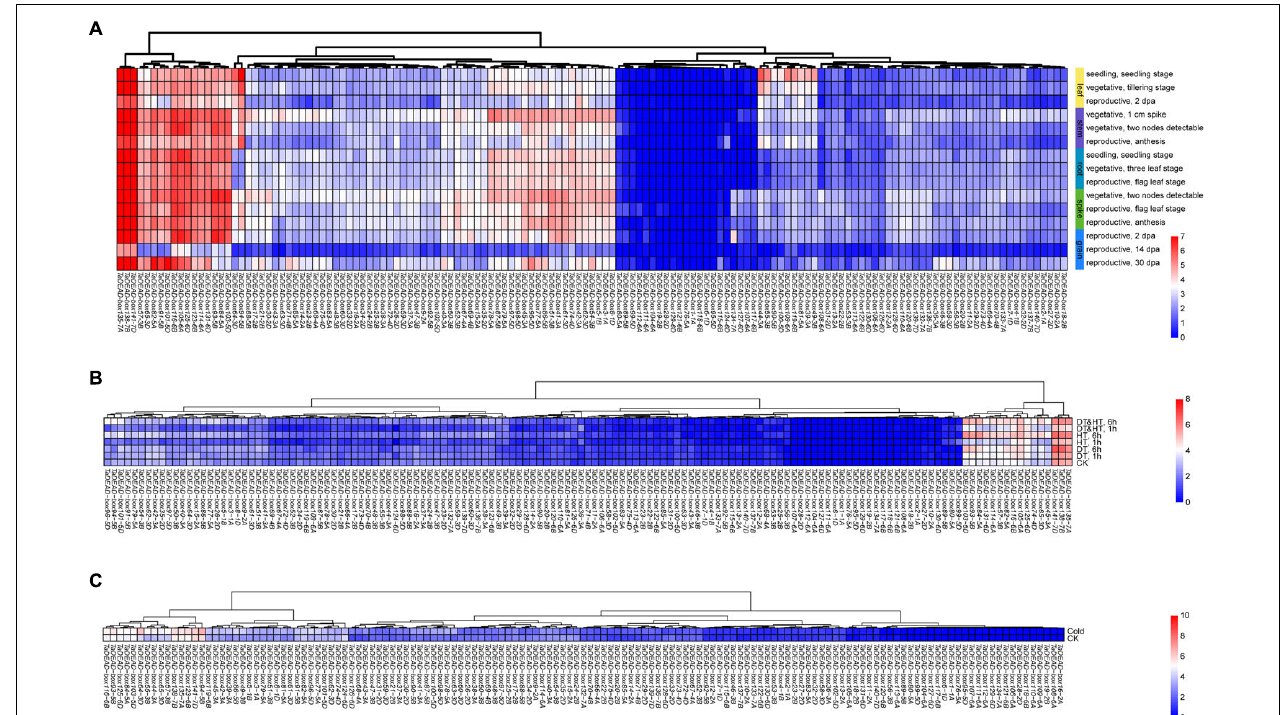
FIGURE 6 | Hierarchical clustering of expression patterns of 141 TaDEAD-box genes using transcriptome data. The expression pattern heatmaps of TaDEAD-box genes were generated through pheatmap package of R project13. The expression levels are indicated by the different color bars, red: higher expression, blue: lower expression. (A) Expression patterns of 141 TaDEAD-box genes in different tissues and development stages. Columns represent 141 TaDEAD-box genes, and rows represent different developmental tissues/stages, including leaf, stem, root, spike, and grain. (B) Expression patterns of 141 TaDEAD-box genes under drought and high-temperature treatments. Columns represent 141 TaDEAD-box genes, and rows represent control and stress treatments. (C) Expression patterns of 141 TaDEAD-box genes under cold treatment. Columns represent 141 TaDEAD-box genes, and rows represent control and cold treatment. CK, control check; DT, drought treatment; HT, high-temperature